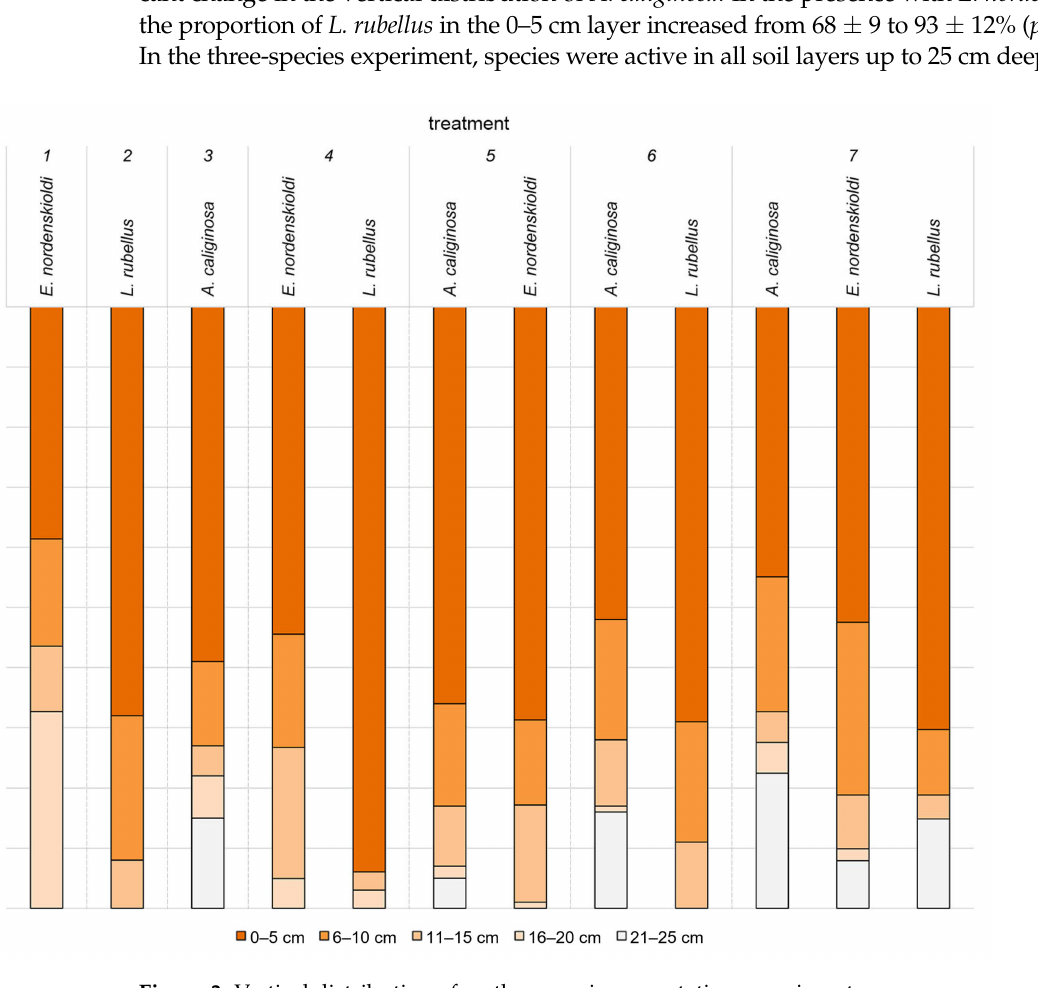
Figure 3. Vertical distribution of earthworms in a vegetation